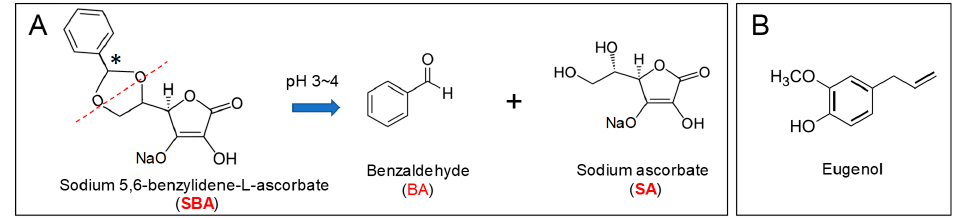
Figure 1. Chemical structure of sodium 5,6-benzylidene- L -ascorbate (SBA) and its hydrolyzed products (benzaldehyde (BA), sodium ascorbate (SA)) ( A ) and eugenol ( B ). SBA has two diastereomers ( S and R configurations at stereogenic center indicated by asterisk in A) present at 31% and 69% (determined by chromato-integrator), respectively [6,7].